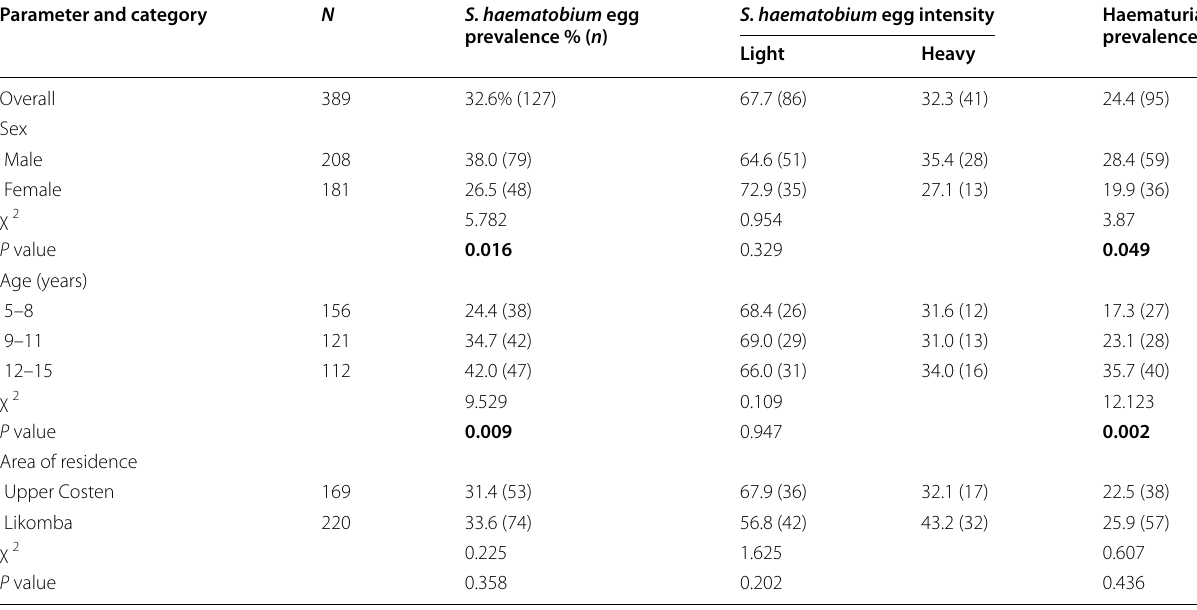
Light intensity of infection, 1–49 eggs/10 mL of urine; heavy intensity of infection,